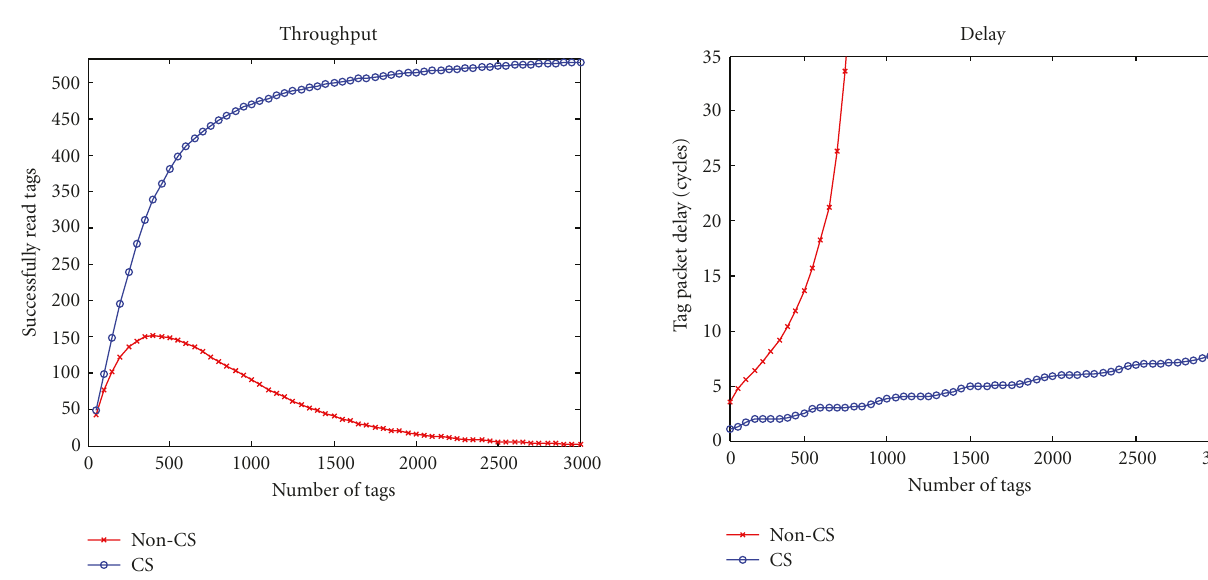
Figure 3: Throughput: number of tags read per second. Figure 4: Delay: average time to read all available tags (the cycle time is set to 1 second).